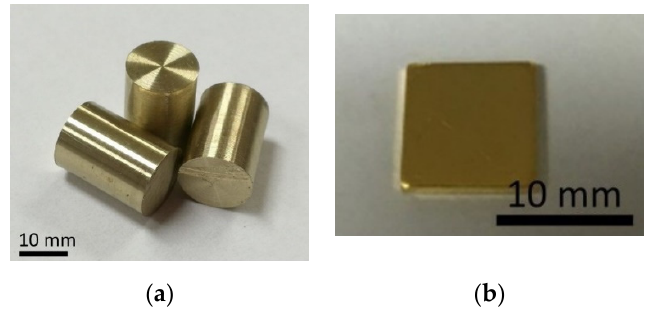
Figure 1. AuCuZnGe sample: ( a ) Cylinders and ( b ) Plate.